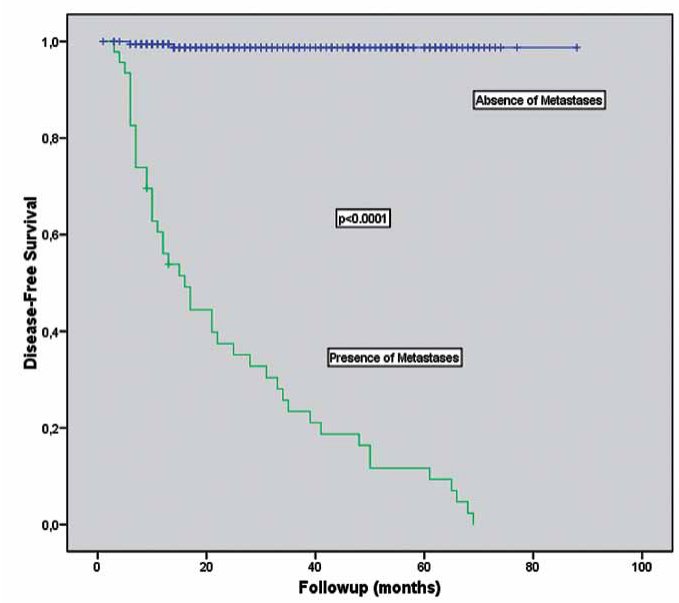
Figure 4 - Among 227 patients, 46 who had metastases had a worse 5-year survival rate. (Kaplan-Meier log rank test p <